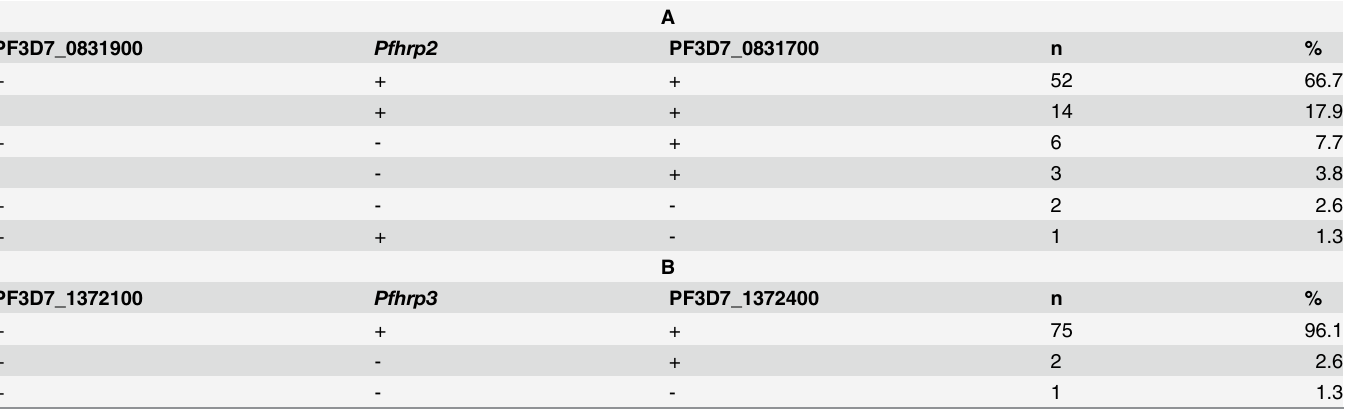
Table 1. Results of PCR amplification of (A) pfhrp2 , (B) pfhrp3 and their respective flanking genes in P . falciparum clinical samples collected in